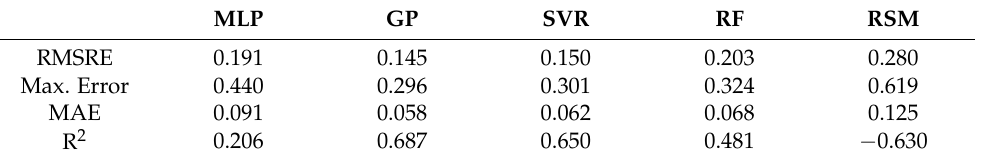
Table 3. Performance metrics values corresponding to Figure 4f.